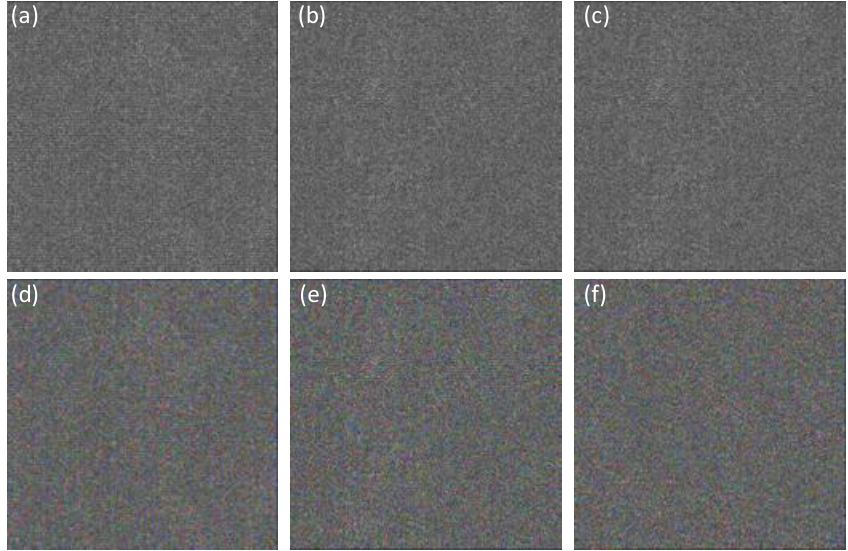
Figure 7. ( a ) Decryped Bayer image of Lena; ( b ) Decryped Bayer image of Parrots; ( c ) Decryped Bayer image of Flowers; ( d ) Decrypted multispectral image of Lena; ( e ) Decrypted multispectral image of Parrots; ( f ) Decrypted multispectral image of Flowers. (k = 0.3 and number of photons = 10 4